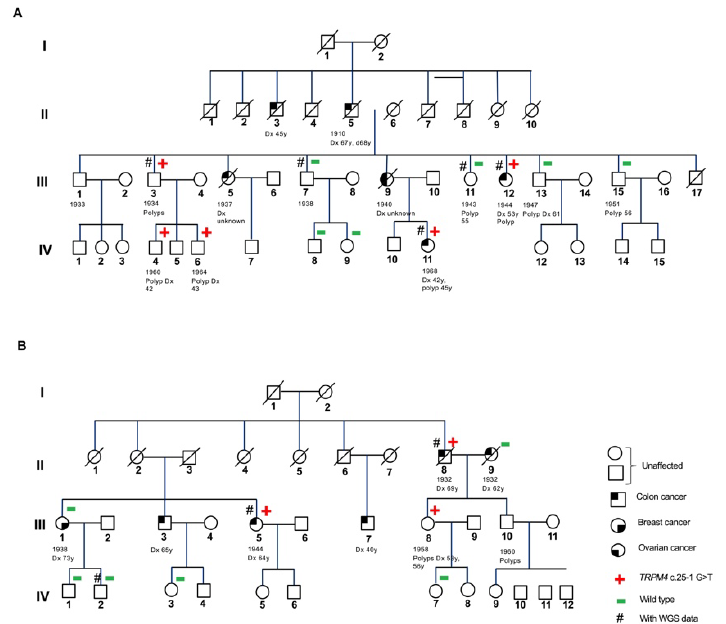
Figure 1. Pedigrees of colon cancer families. ( A ) Family 8 with CYBA c.246delC variant. ( B ) Family 11 with TRPM4 c.25-1 G > T variant.